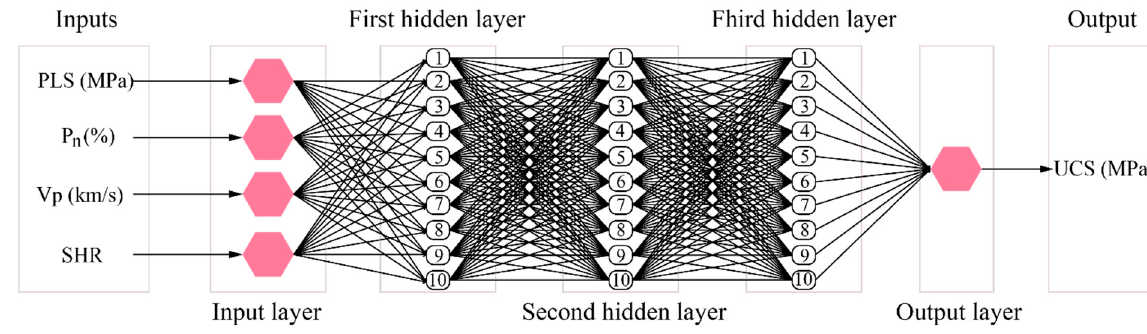
Figure 7. Considered DELM architecture.